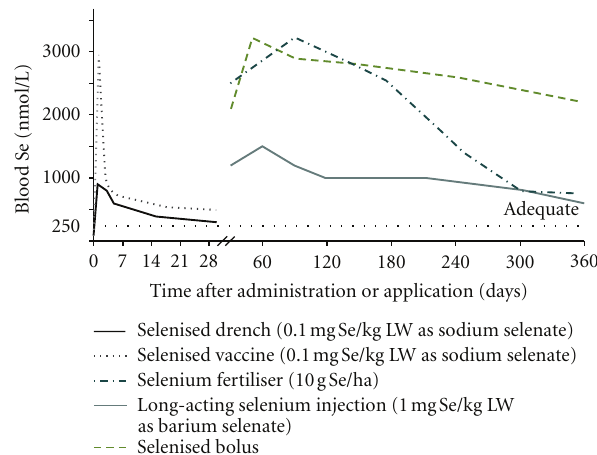
Figure 1: Comparison of the e ff ects of administration or applica- tion of a selenised oral drench, a selenised vaccine, a Se-amended fertiliser, a Se-containing intraruminal bolus, and a long-acting Se injection on the blood Se concentrations of sheep. Blood Se > 250nmol/L indicates adequate Se status, above which animals are unlikely to respond to supplementation in terms of improved performance or